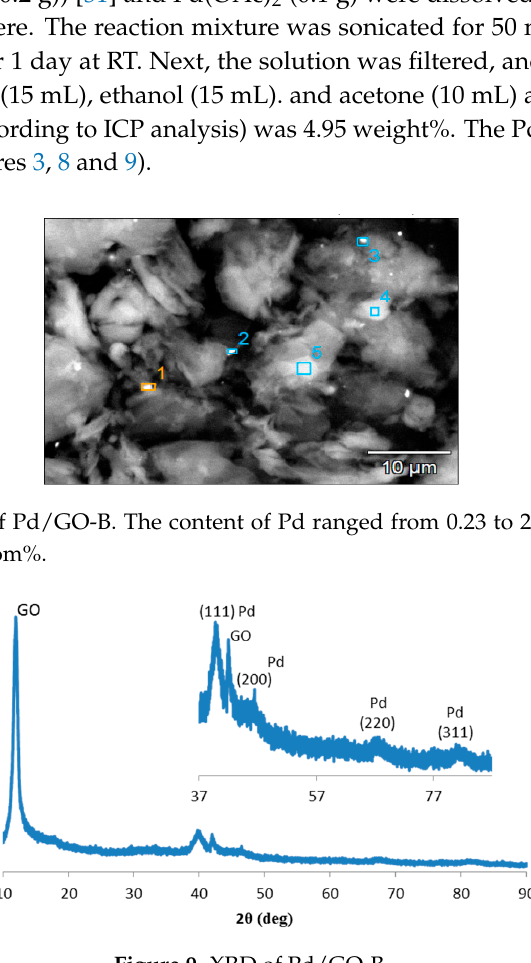
Figure 9. XRD of Figure 9. XRD of Pd/GO-B. Figure 9. XRD of Pd/GO-B. Figure 9. XRD of Pd/GO-B.